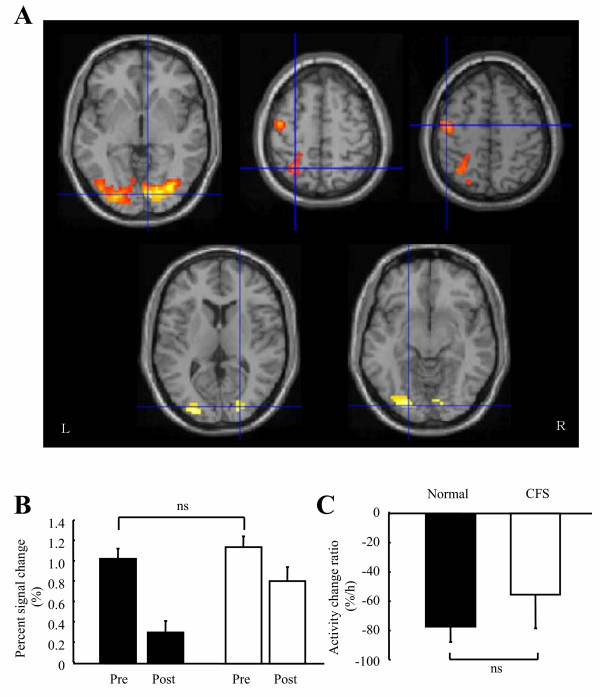
Activity related to visual search. (A) Statistical parametric maps activated by visual search (random-effect analysis of 13 subjects, P < 0.05, corrected). In order to identify brain regions activated by visual search, we calculated percent signal change evoked during present and absent trials as compared with that for null trial. Anatomical locations were mapped on axial template brains. Top: Sections passing through visual cortices (left), intraparietal sulcus (middle), and precentral gyrus (right) in the pre-fatigue session. Bottom: Sections passing through right visual cortex (left) and left visual cortex (right) in the post-fatigue session. Crossing line indicates the local activity maximum of each brain region. The right (R) and left (L) sides are indicated. (B) Activity in the visual cortices during the visual search in the pre- (Pre) and post-fatigue (Post) sessions of the normal and CFS patient groups. Magnitude of the activity was calculated as the peak signal change (%) averaged across the activated areas. (C) Activity change rate in the visual cortices during the visual search of the normal and CFS patient groups. Activity change rate (%/h) was calculated as change of activity in the visual cortices during the visual search from pre-fatigue to post-fatigue sessions divided by the session time (hour) of the fatigue-inducing period × 100. Data are mean and SEM. ns, no significant difference (unpaired t-test). Closed columns, normal subjects; open columns, CFS subjects.